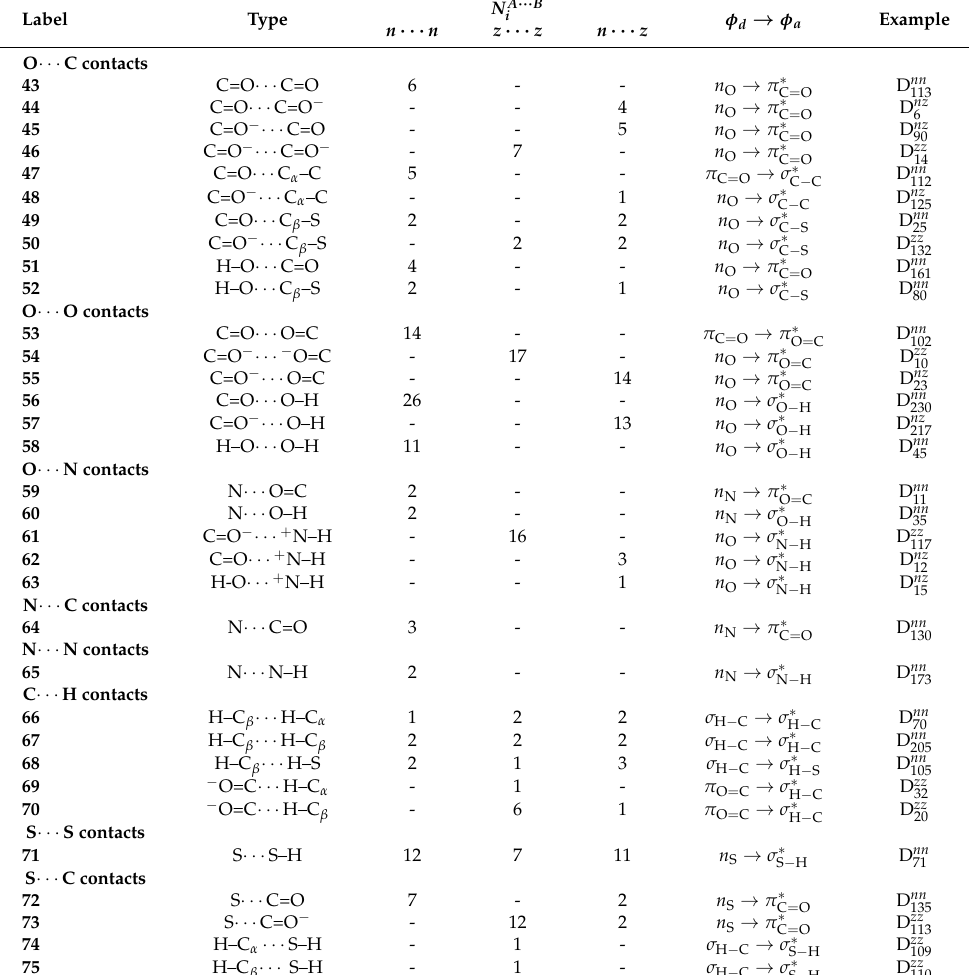
Table 4. Properties of the “exotic” intermolecular contacts found in the cysteine dimers. N A ··· B the number of times that the interaction appears in the corresponding type of dimers. φ d , φ a are the charge donor and acceptor orbitals as identified from NBO. An example of a dimer containing each particular interaction is given in the rightmost